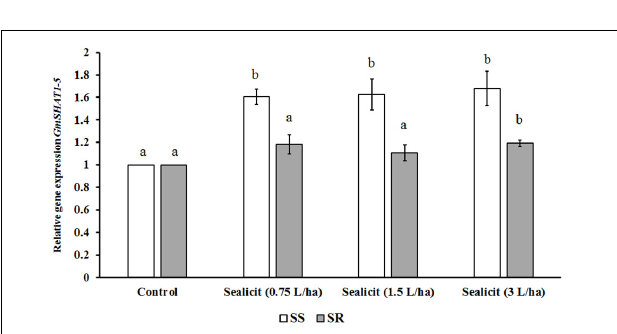
FIGURE 4 | Relative expression of GmSHAT1–5 in soybean pods treated with Sealicit TM . Different letters within the same soybean variety indicate statistically significant differences between the treatments based on one-way ANOVA Tukey’s HSD test at p ≤ 0.05. Number of biological replicates ( n =